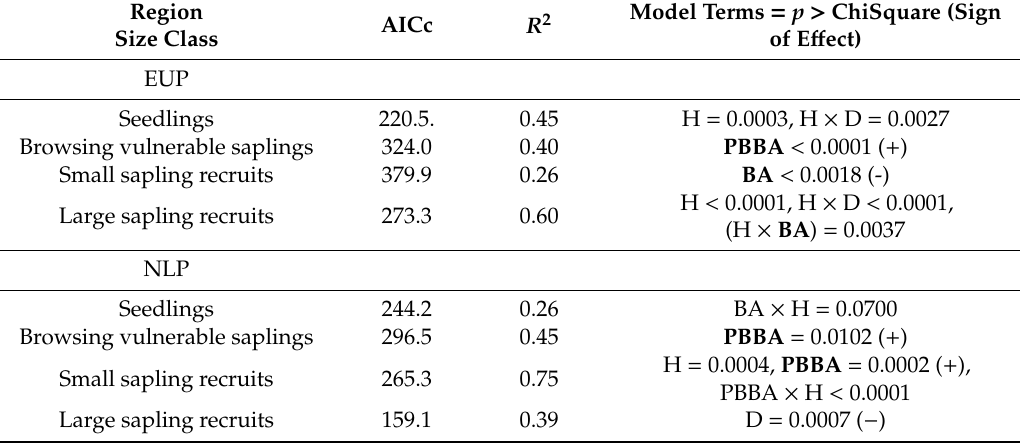
Table 4. Summary of generalized negative binomial models of F. grandifolia stem counts: H = habitat type, D = deer use, BA = current basal area, STBA = (beech) seed tree basal area, PBBA = preharvest beech basal area. To minimize overfitting, each of the three estimates of the basal area (i.e., BA, STBA, PBBA) was combined in a complete factorial with habitat type and deer use for modelling. Model summaries shown are those with the best support. Factors shown are those retained in final models using elastic net estimation and AICc validation with Prob > ChiSquare < 0.10. Signs of main e ff ects ( + or -) are in